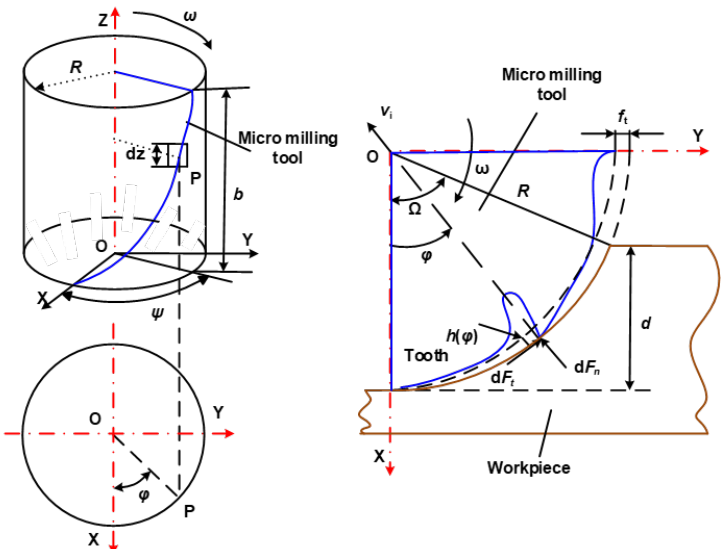
Figure 1. Different cutting model of peripheral milling [29].